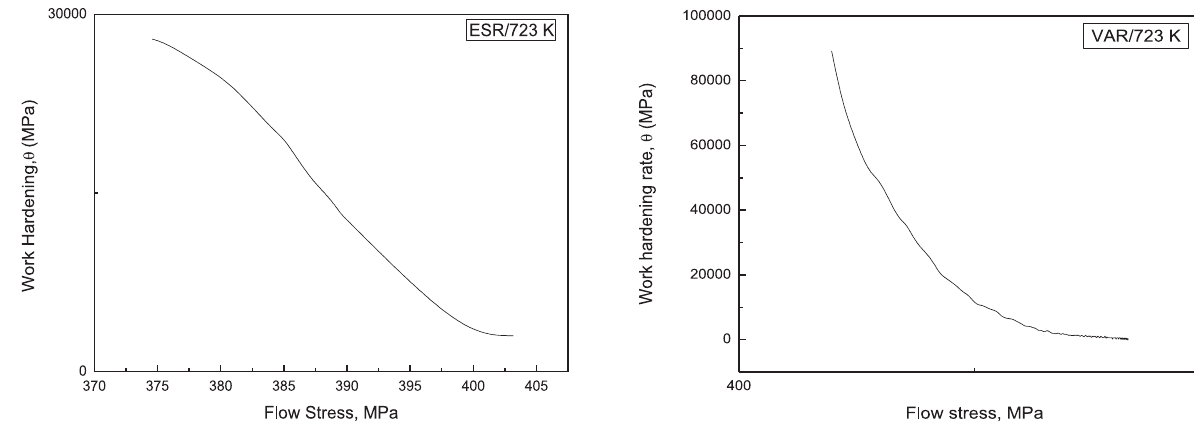
Fig. 9: Typical plots of work hardening rate as a function of flow stress in the non DRX regime.